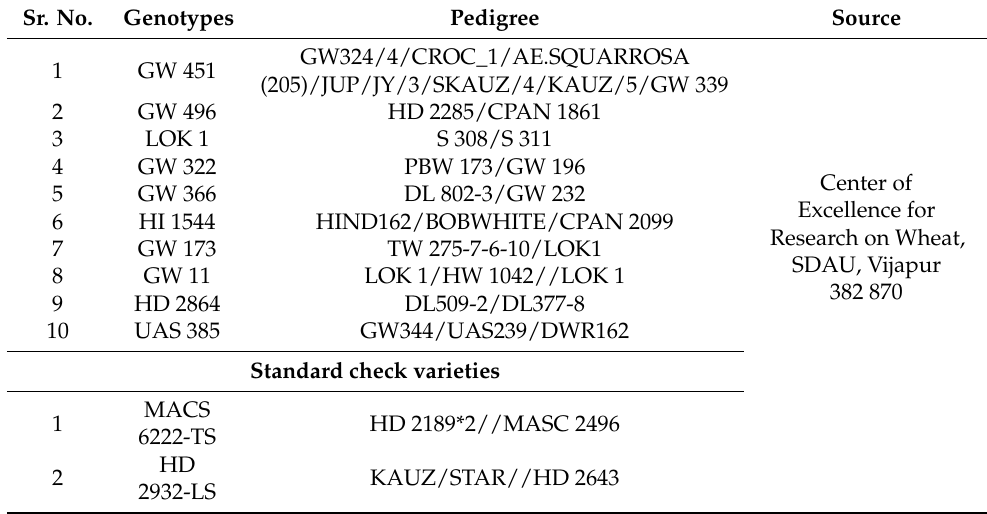
Table 1. List of genotypes and their pedigree. Sr.